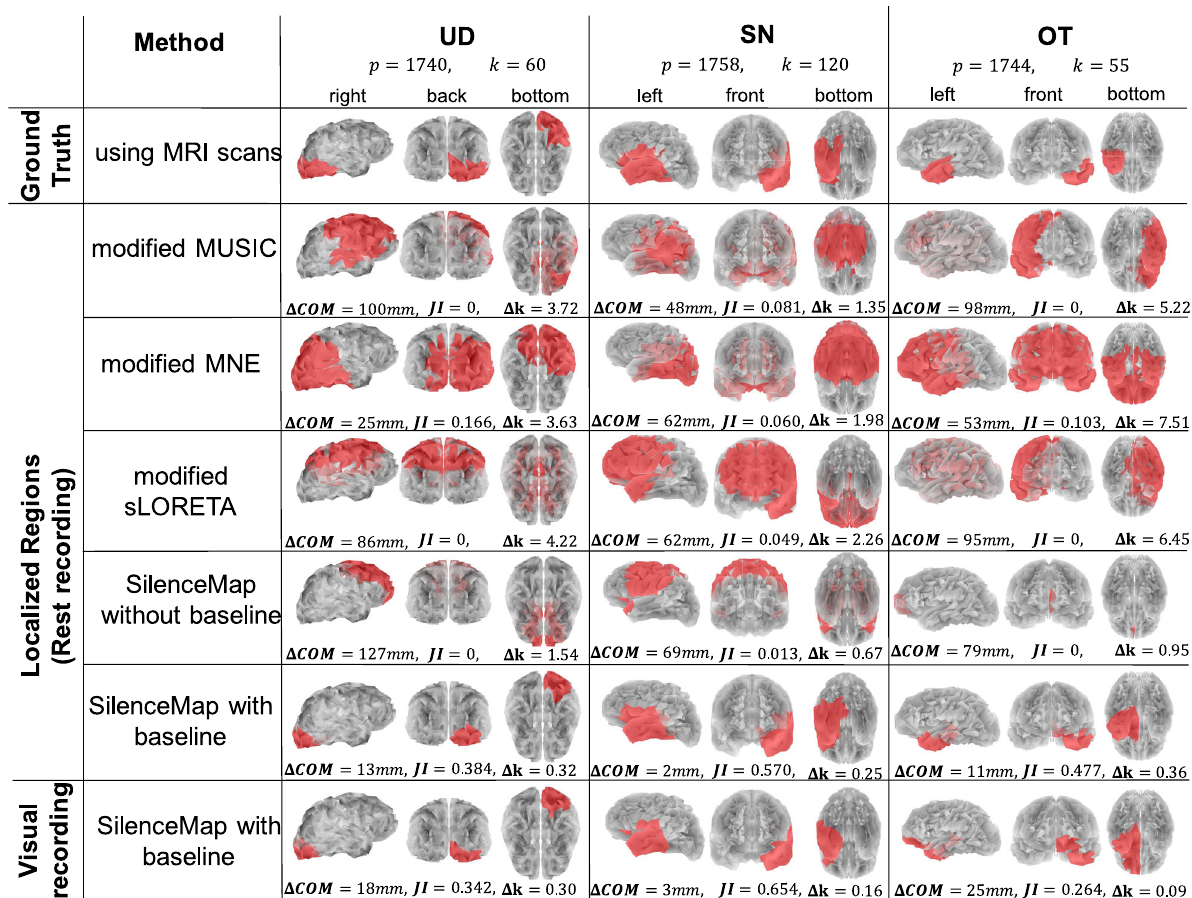
Fig. 3 Performance of SilenceMap on a real EEG dataset. The fi rst row shows the extracted ground truth regions of silence (red regions) overlaid on the resected cortical region of three patients based on their symmetric brain models extracted from the structural MRIs (see the MRI scans in Fig. 2); the second, third, and fourth rows show the performance in localization of the silent region using modi fi ed source localization algorithms (MNE, MUSIC, and sLORETA), through both visual illustration (red regions) and using performance metrics of center-of-mass (COM) distance ( Δ COM), Jaccard Index (JI), and size error ( Δ k ). The fi fth row shows the performance of SilenceMap without baseline, and the last two rows show the localization performance of SilenceMap with baseline, based on the Rest and Visual recordings respectively. p is the total number of sources in each brain model, and k is the size of ground truth region of